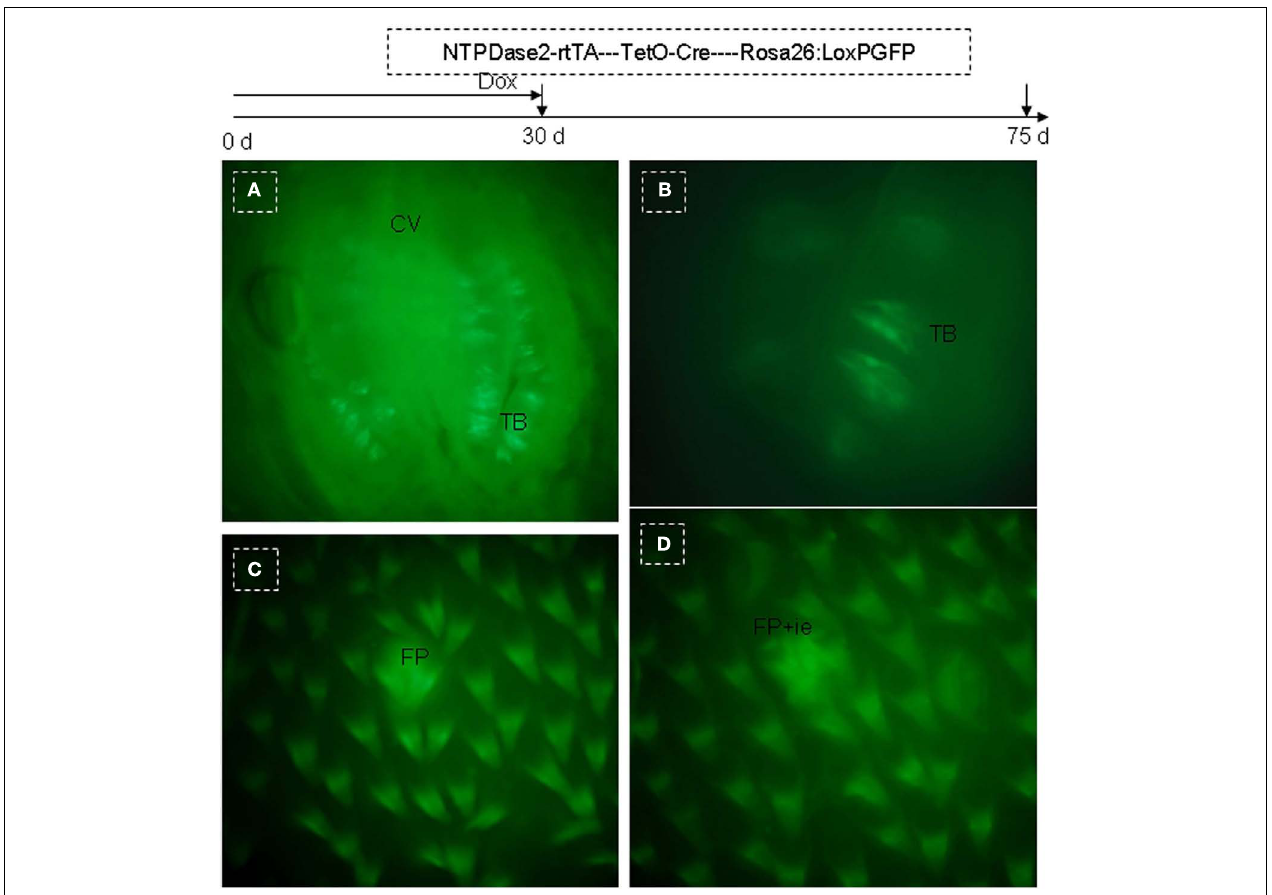
resolution image of a taste bud. (C) GFP was observed in filiform papillae. (D) GFP was observed in filiform papillae and interpapillary epithelium. CV, circumvallate papillae; FP, filiform papillae; ie, interpapillary epithelia;TB, taste